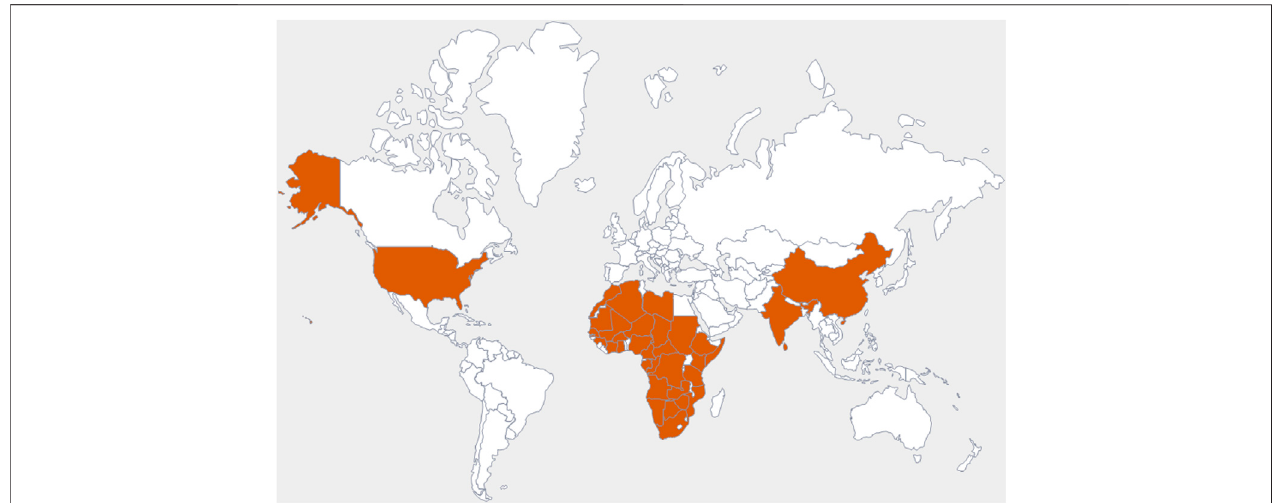
FIGURE 1 | Commonly observed geographical distribution of Alternanthera species, indicated in dark orange.